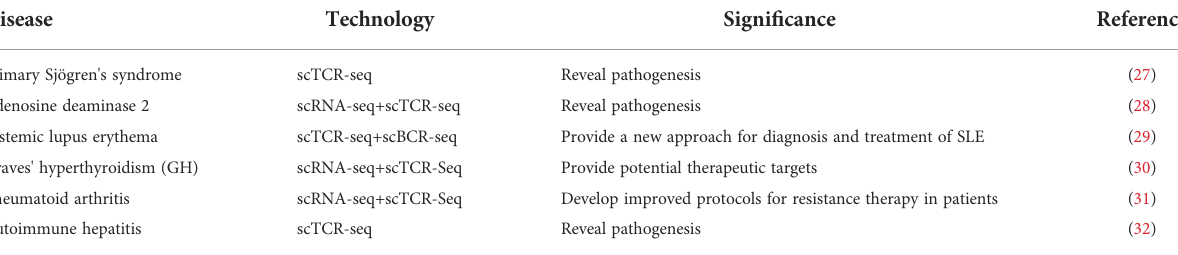
TABLE 3 Summary of studies on the application of single-cell TCR/BCR sequencing technology in autoimmune diseases.